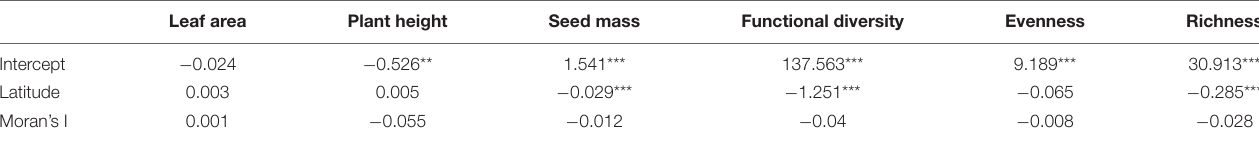
TABLE 1 | Outcomes of generalized least squares models of functional traits, functional diversity, and pollen evenness and richness against latitude in North America. Leaf area